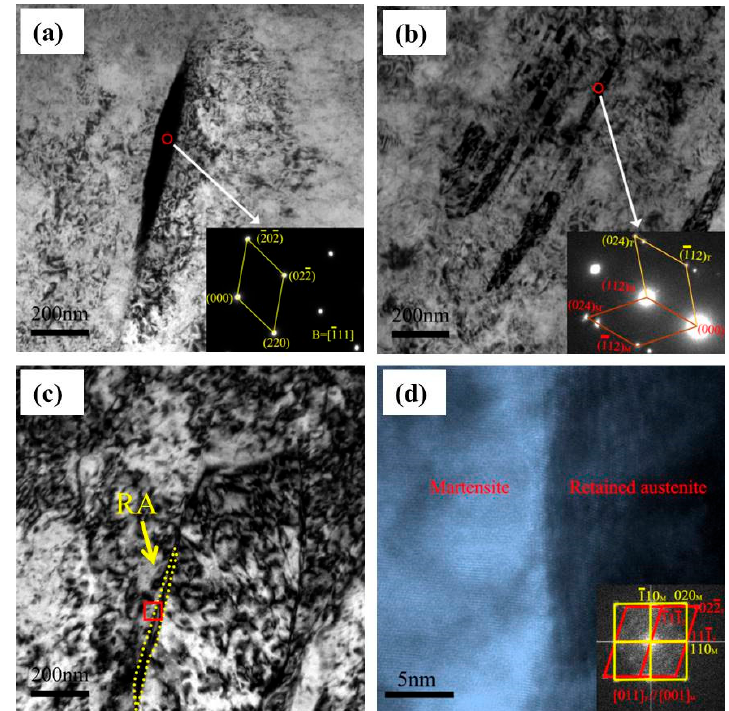
Figure 9. TEM images showing the retained austenite, twin martensite, and the orientation relationship between retained austenite and martensite. ( a ) Retained austenite and surrounding martensite; ( b ) twin martensite; and ( c ) the orientation relationship between retained austenite and martensite. ( d ) High-resolution TEM micrograph indicating N-W relation of the selected red rectangle region in ( c ).